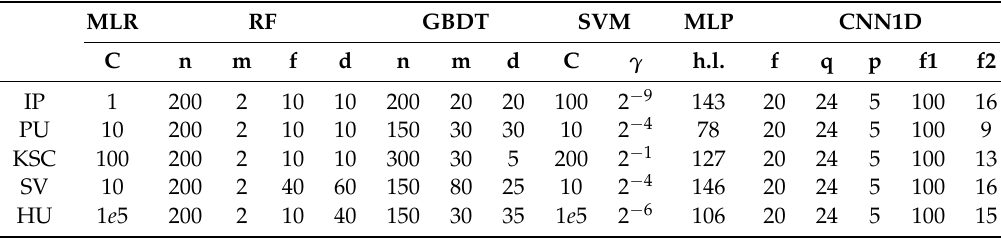
Table 3. Selected training parameters of the different tested